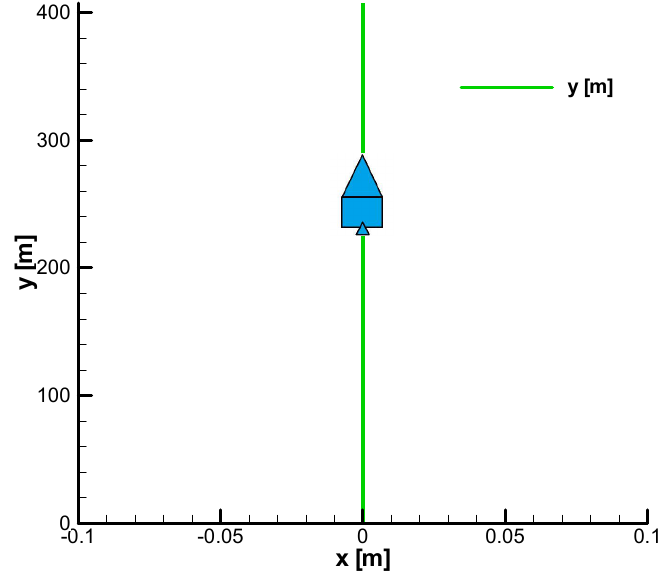
Figure 7. Vertical ascending—descending trajectory.